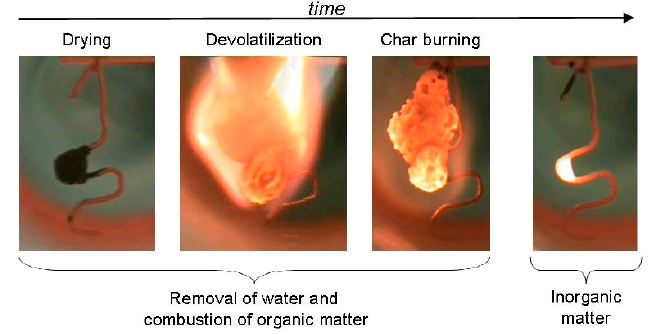
Figure 2. Black liquor droplet combustion process.